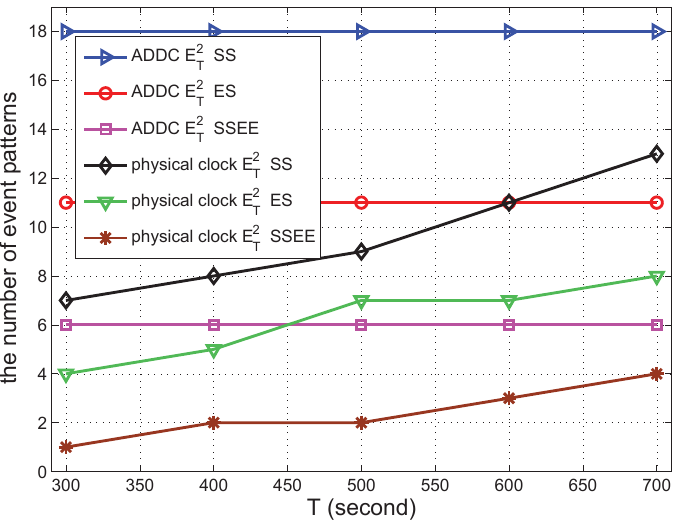
Figure 11. The number of event patterns vs.